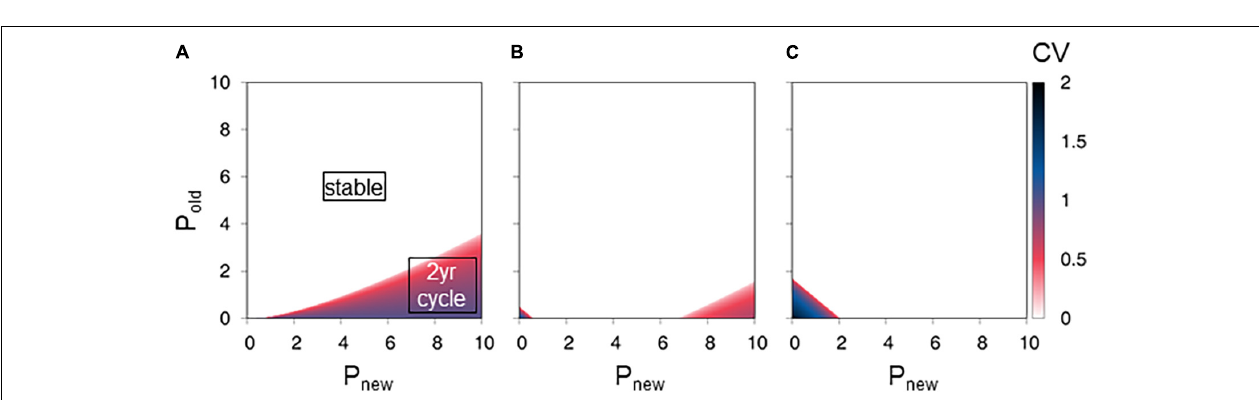
FIGURE 3 | Effect of net photosynthesis rate in old leaves on new shoot production. The figures show the final state coefficient of variation (CV) values from a series of P old values of (A) 0.0, (B) 1.0, and (C) 2.5. The color gradation bar represents the CV. Parameter settings of the upper-left blue region generate the more than 2-year cycles or chaotic condition of production. Parameter settings of the central white region generate stable production. Parameter settings of the lower-right red region generate the 2-year cycles.